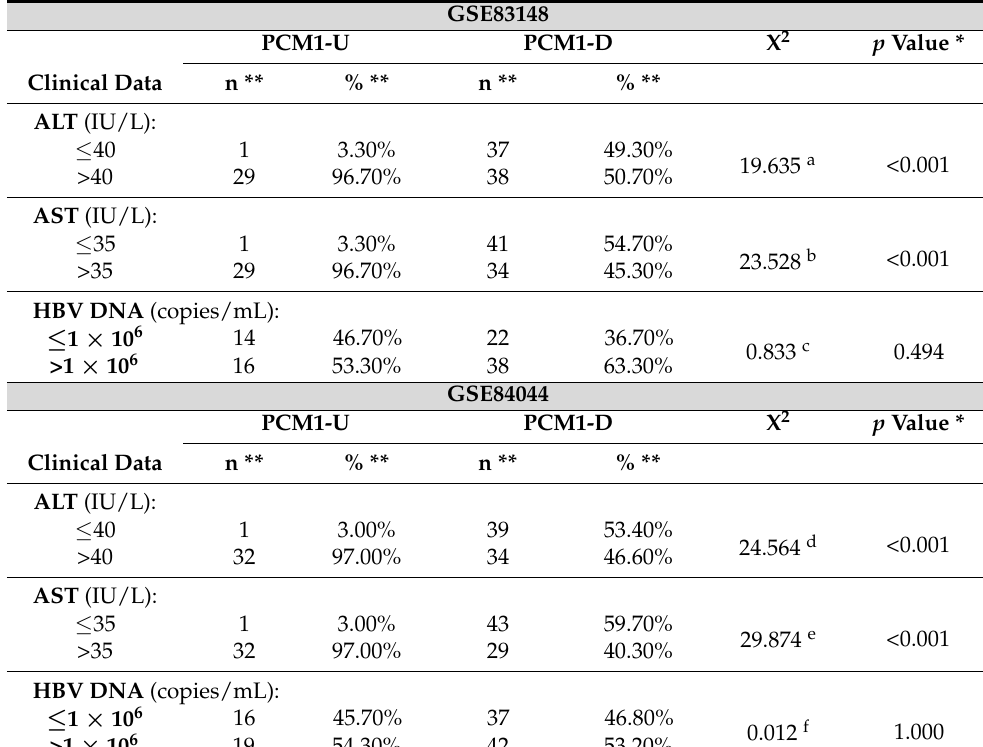
Table 2. Association of PCM1 with ALT, AST and HBV DNA in GSE83148 and